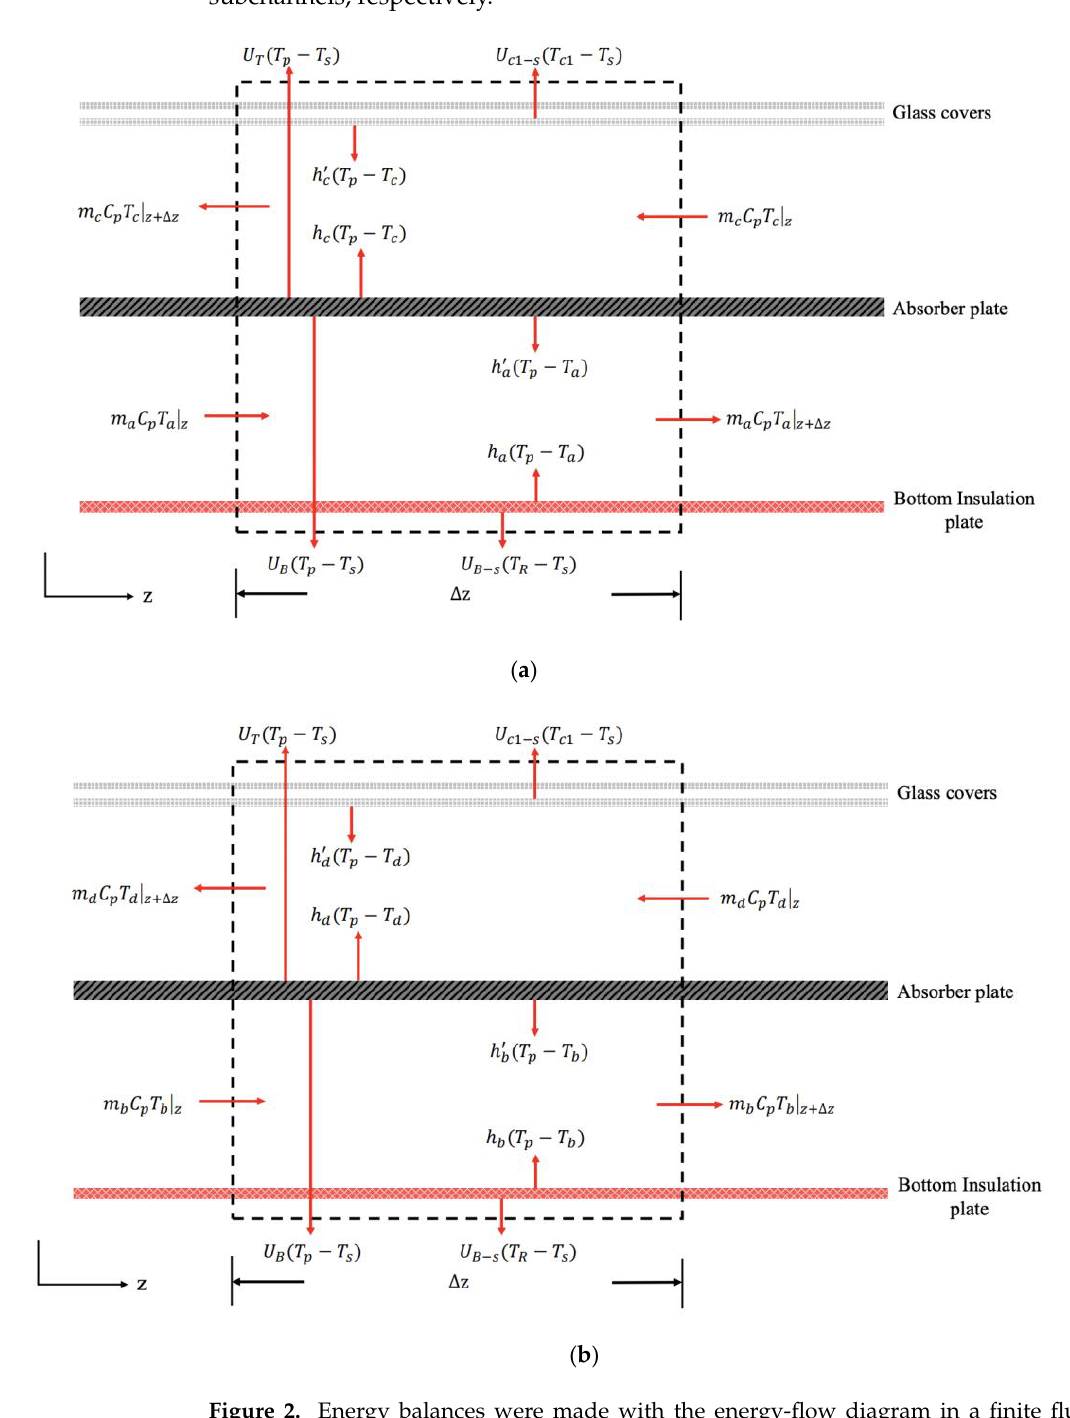
Figure 2. Energy balances were made with the energy-flow diagram in a finite fluid element: ( a ) Subchannels on the left-hand side; ( b ) Subchannels on the right-hand side.